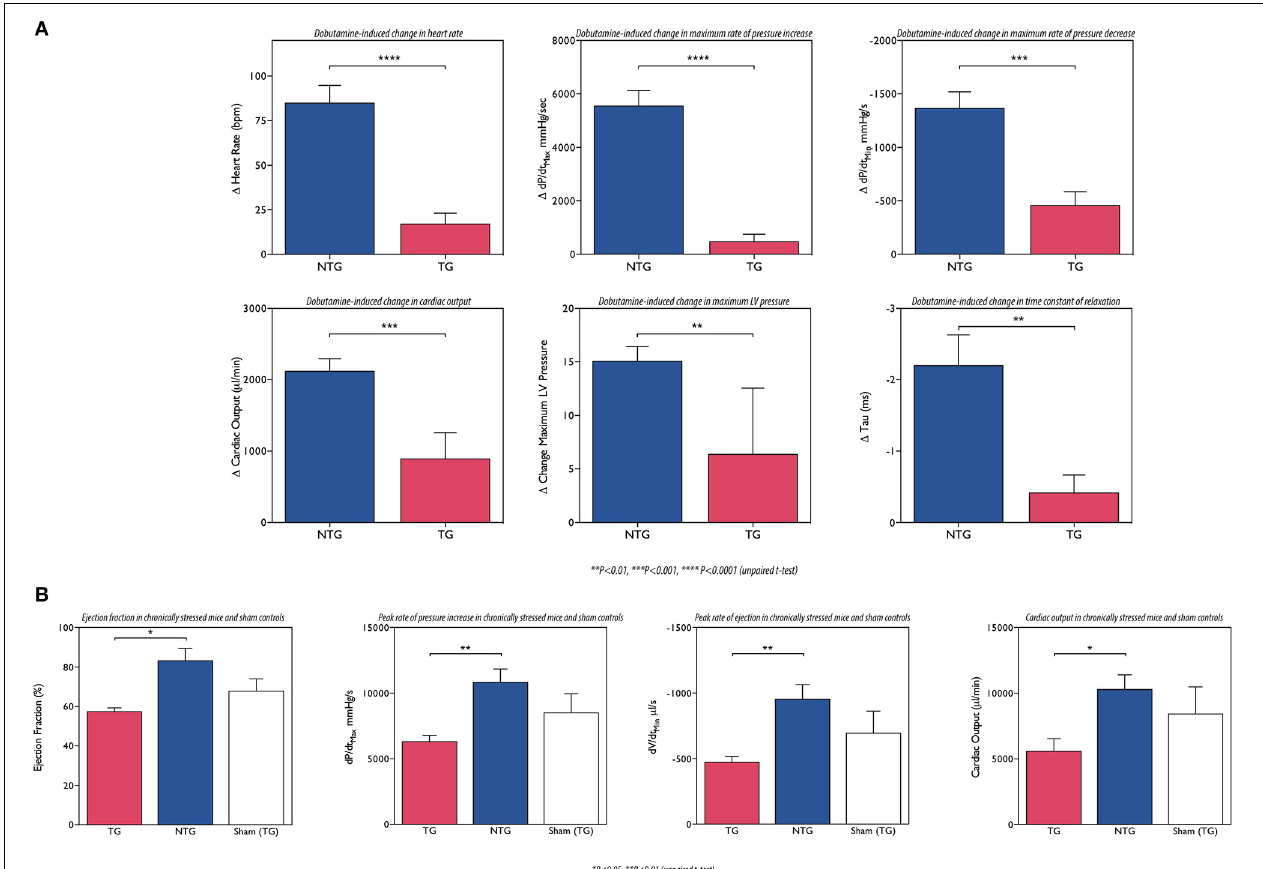
FIGURE 6 | (A) The ACTC E361G mutation blunts the lusitropic, inotropic and chronotropic response to dobutamine in vivo : mice were examined using a pressure volume catheter. The dobutamine-induced acceleration of relaxation (peak rate of relaxation and time constant of relaxation) was significantly lower in ACTC E361G mice indicating a blunted lusitropic response. The inotropic response to dobutamine was also blunted in ACTC E361G mice as indicated by a blunted increase in maximum pressure and the peak rate of pressure increase. Furthermore, dobutamine-induced increase in heart rate (chronotropic effect) was also blunted. Taken together with the attenuated increase in cardiac output these data suggest a significantly diminished